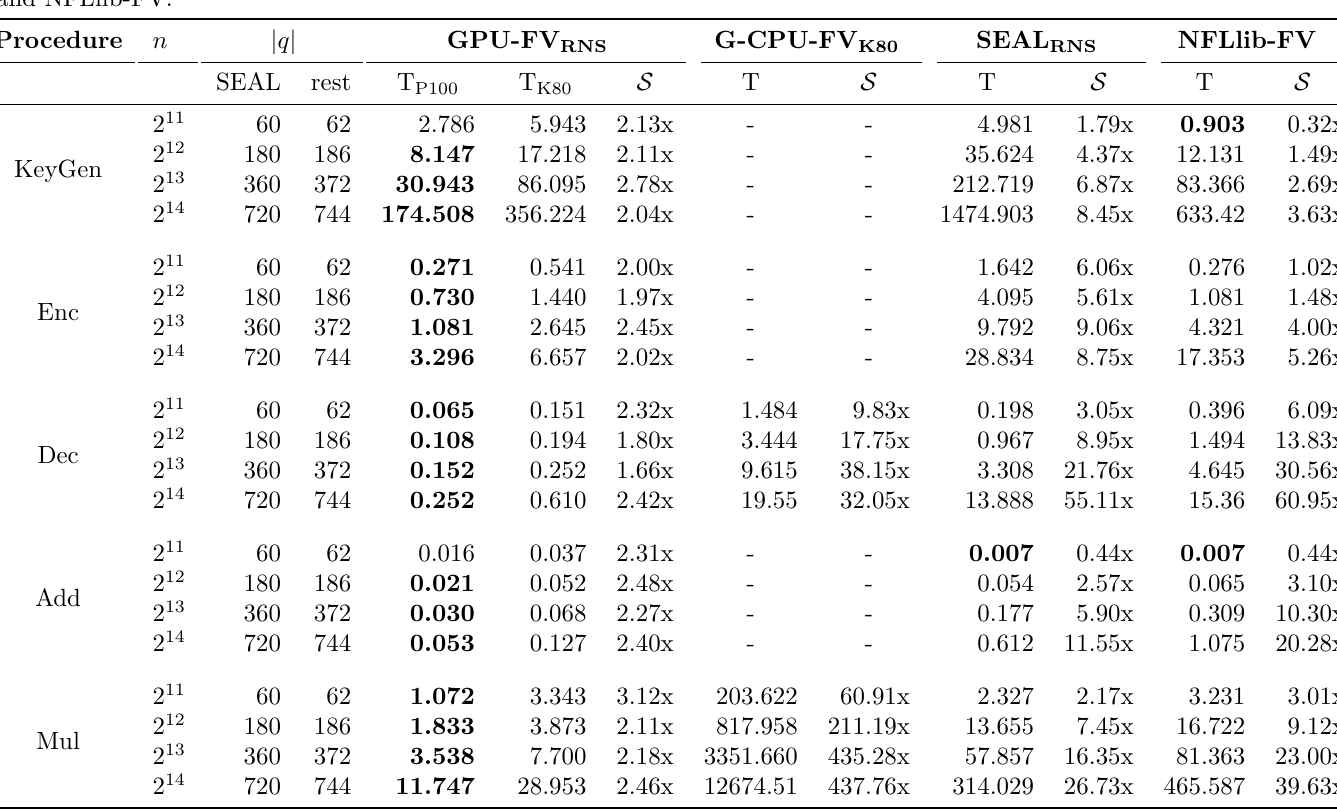
Table 5: Latency T (millisecond) averaged over 500 runs of the FV primitives and speedup S for the full GPU implementation(GPU-FV RNS ) on P100 and K80, cooperative CPU-GPU FV(G-CPU-FV K80 ) on K80, SEAL-FV RNS (v2.3.0-4) and